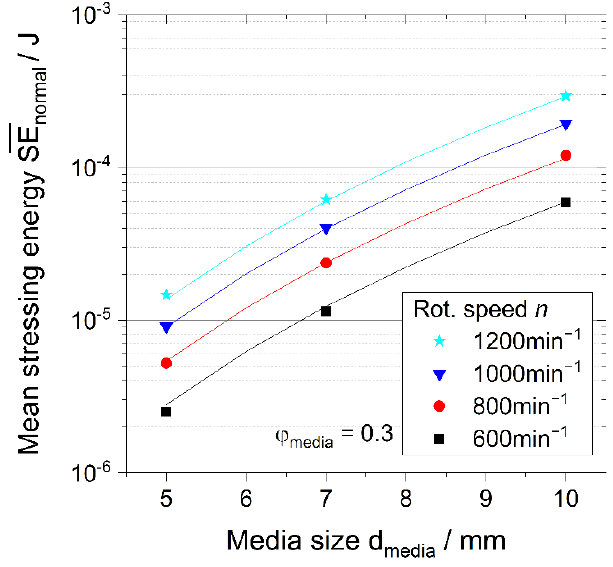
Figure 5. Mean stressing energy of head-on collisions as a function of media size for varied rotational speeds (fit functions are based on Equation (13)). Table 7. Variables for model equation (Equation (14)) to describe the normal stressing energy based on rotational speed n (in min − 1 ) and media size d media (in mm).